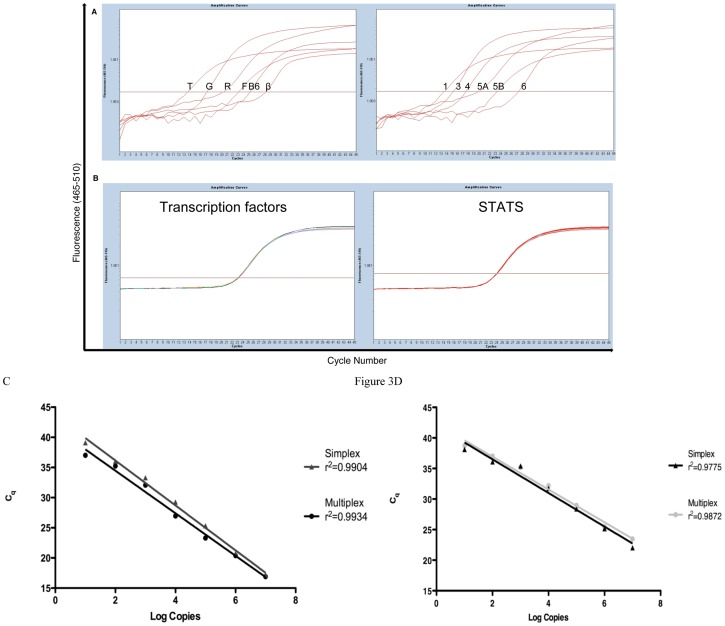
Primer competition in the multiplex pre-amplification PCR and Linearity/Dynamic range of the assay.A) Known concentrations of Tbx21 (T), Gata3 (G), Rorγt (R), Foxp3 (F), Bcl-6 (B6), and ß-actin (B) DNA products (1, 1/10,1/100, 1/1000, 1/10000 and 1/100000 respectively), as well as, stat1, 3, 4 5A, 5B and stat6 (1, 1/10,1/100, 1/1000, 1/10000 and 1/100000 respectively) were mixed in the 1st round RT-PCR step. The different ratios of each product detected, reflect the initial dilutions of the different products, Cq were ∼2.8 cycles apart. The same concentration of 1/1000 was used for the all products; the Cq was ∼22.5 with a CV of 0.3%. C) ß-actin plasmid standards from 107 to 10 copies were used in the 2 step multiplex assay and a simplex real-time PCR assay. The r2 values for the simplex (triangle) and the multiplex (circle) reaction are r2 0.9904 and r2 0.9934 respectively. D) Bcl-6 plasmid standards from 107 to 10 copies were used in the 2 step multiplex assay and a simplex real-time PCR assay. The r2 values for the simplex (triangle) and the multiplex (circle) reaction are r2 0.9755 and r2 0.9872 respectively. All replicates were performed in triplicate.